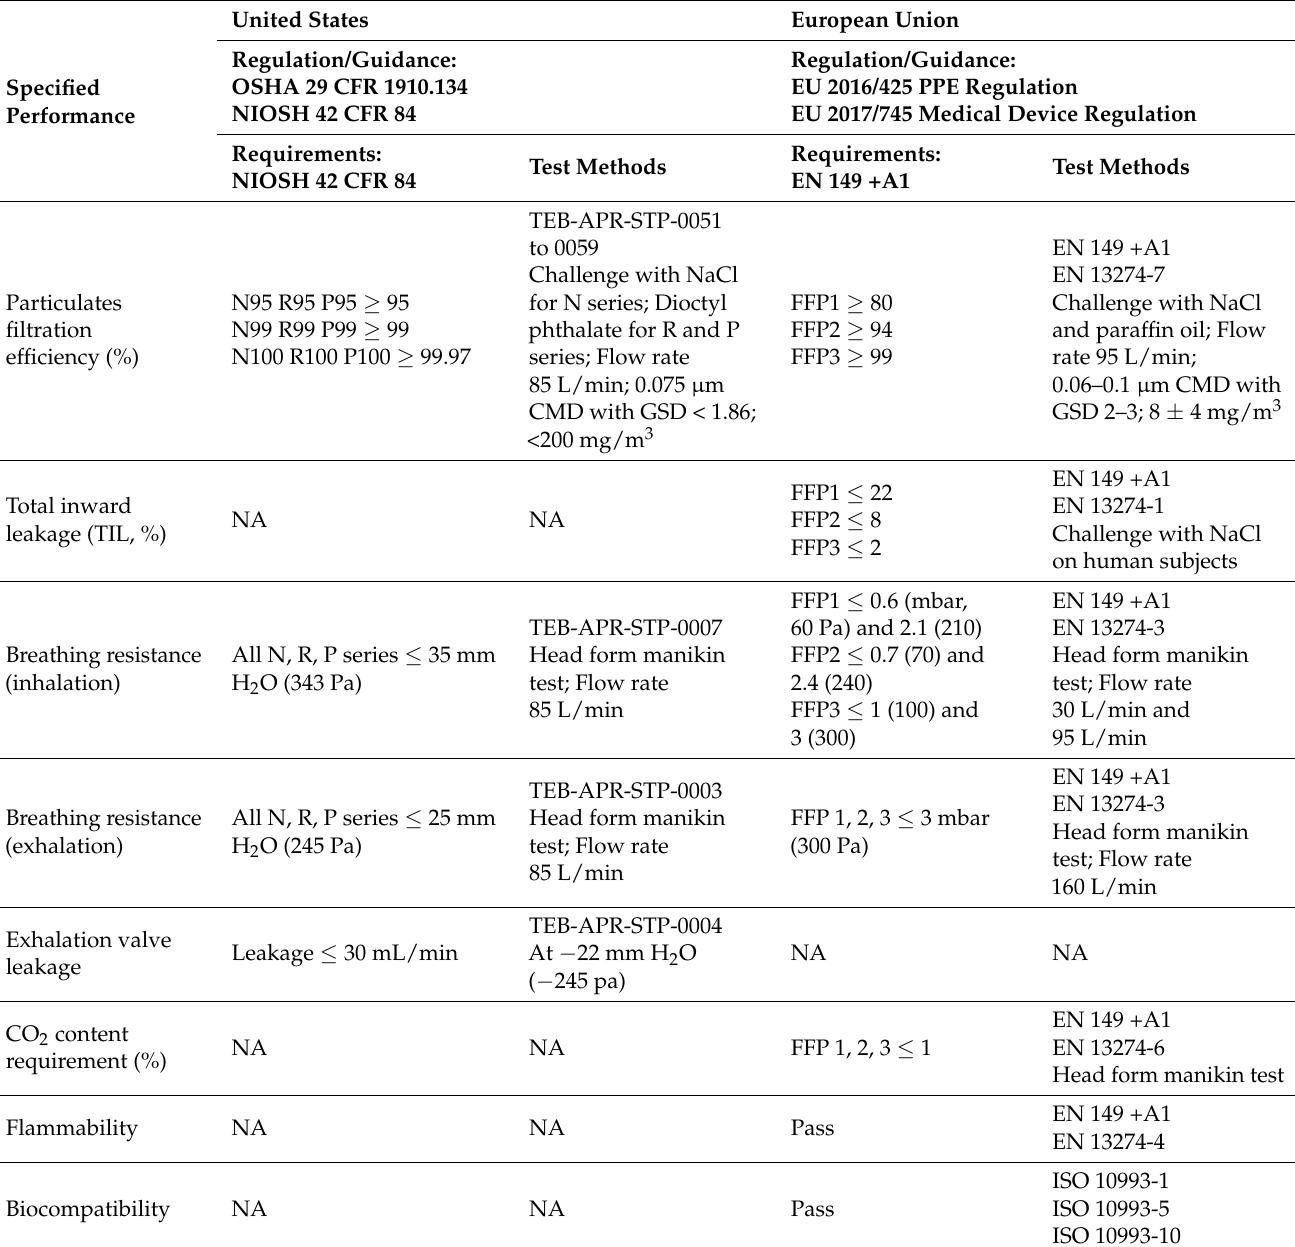
Table 2. FFR regulations, specifications, and test methods